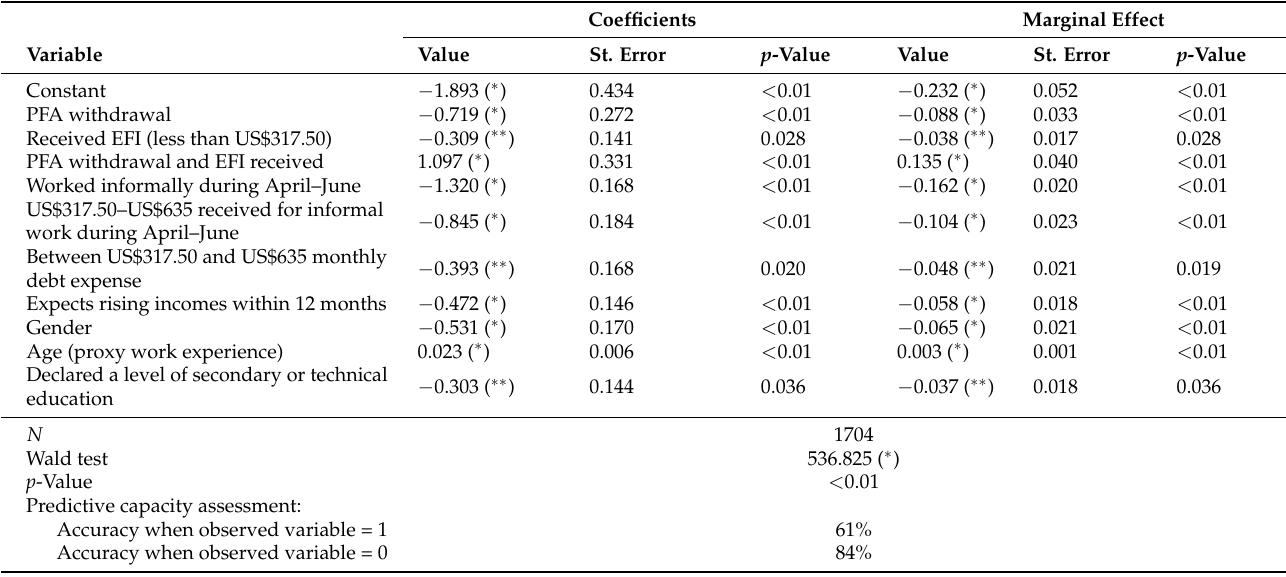
Table 3. Main results of the estimation of logit model. N are the number of observations in which the worker declared to be over 80 and 90 years of age were eliminated (1% of the sample). ∗ Significative value at 1% of confidence level. ∗∗ Significative value at 5% of confidence